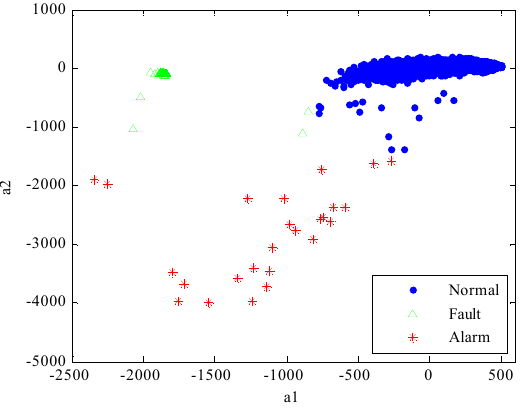
Figure 5. K ‐ means clustering result of the loading matrix A , a 1 and a 2 are the first two columns of A .